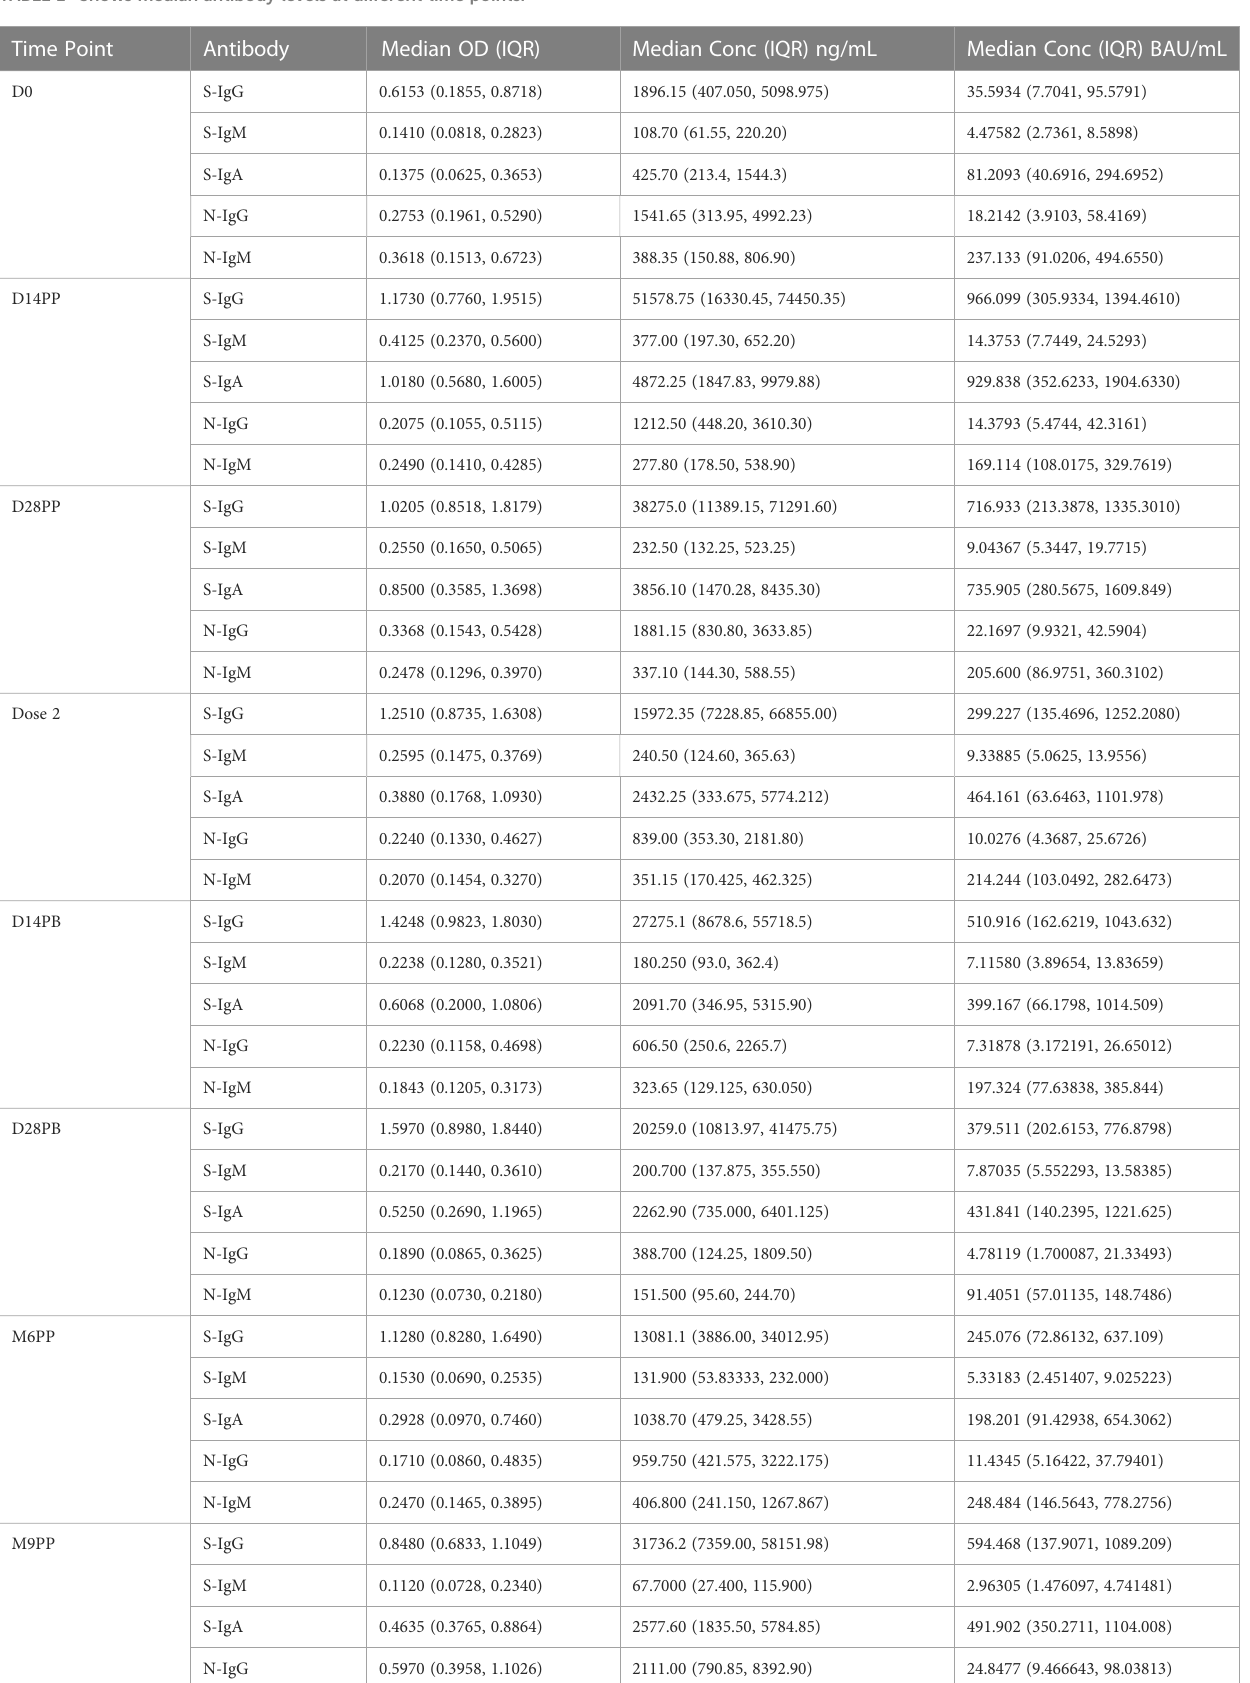
TABLE 1 Shows median antibody levels at different time